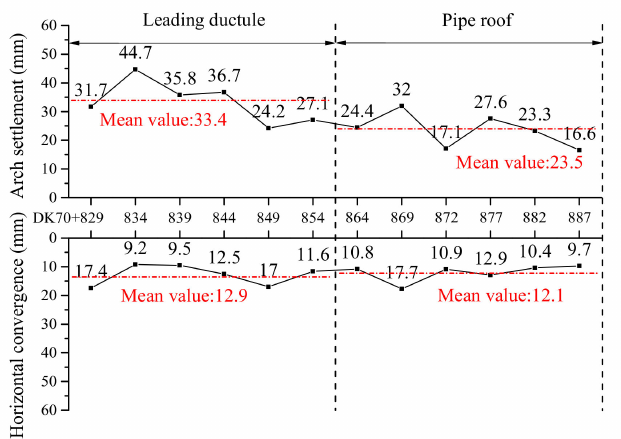
Figure 10. Tunnel displacement–time curves of section DK70 + 869.